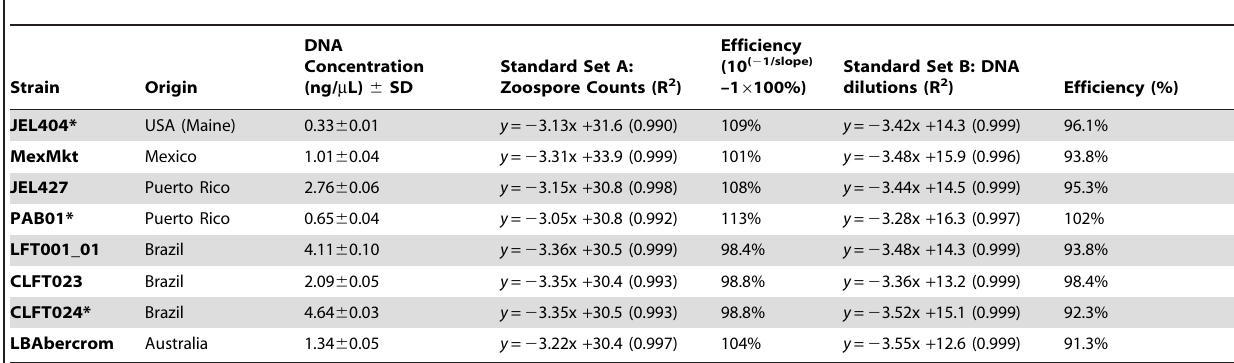
Table 1. Standard curve equations, reaction efficiencies and starting DNA concentrations of eight Batrachochytrium dendrobatidis